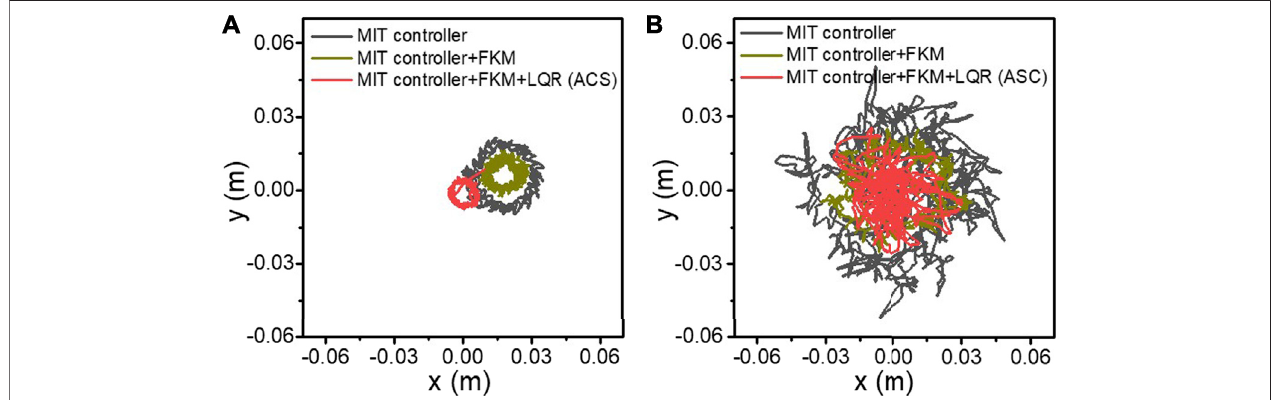
FIGURE 6 | The CoM trajectory of the robot during the spinning experiments in simulation (A) and in the hardware platform (B) . The black lines represent the CoM trajectorywithmerelyanMITcontroller.ThebrownlinesdenotetheCoMtrajectoryafteraddingFKM.TheredlinesrepresenttheCoMtrajectoryafteraddingFKMandLQR.